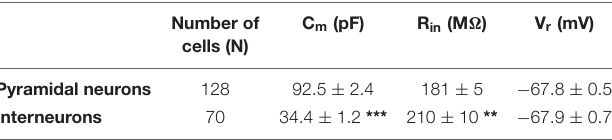
TABLE 2 | Comparison of the principal passive electrophysiological properties of pyramidal neurons and GABAergic interneurons of the PRC. Number of C m (pF) R in (M (cid:127) ) V r (mV) cells (N) Pyramidal